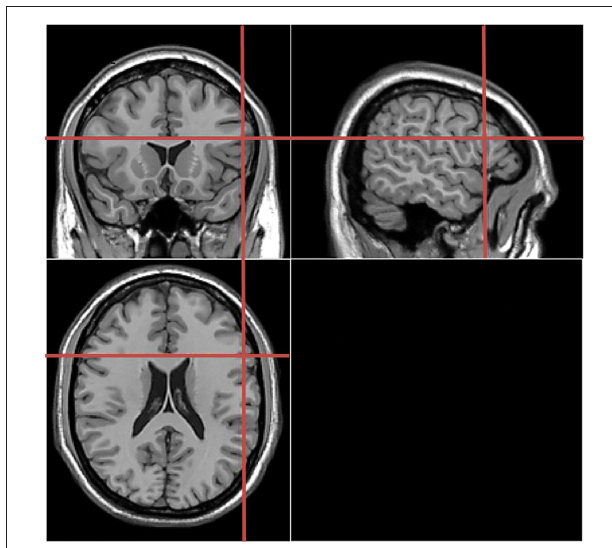
FIGURE 2 | Coronal, axial, sagittal views of the stimulated site left inferior frontal gyrus, Montreal Neurological Institute (MNI) coordinates: − 55, 18, 21, depicted on a standard template from MRIcro.